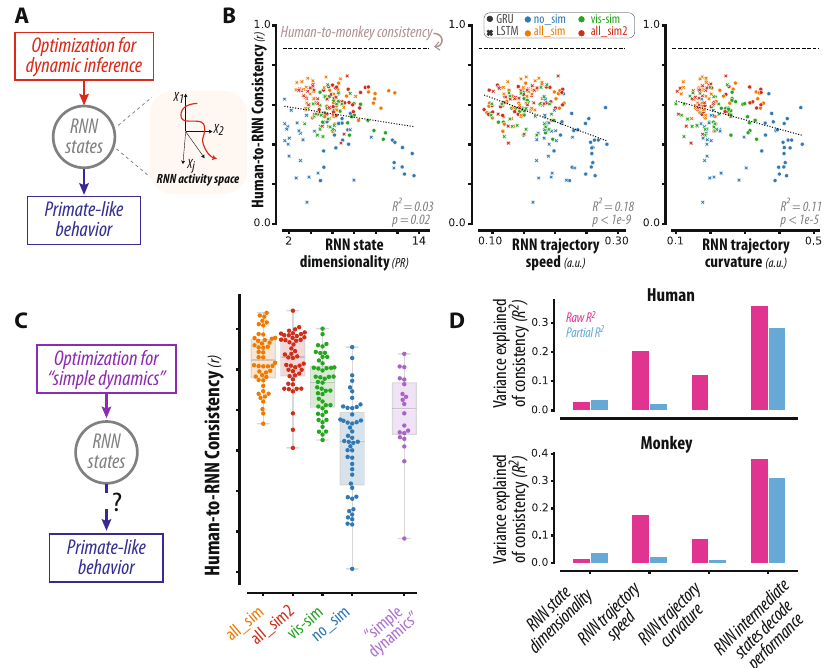
Fig. 4 | RNN Dynamics underlying primate-like behavior. A Optimization for dynamic inference ability in fl uences the network behavior by acting via the inter- mediary of its internal representations. We characterized the structure of the internalrepresentationsofRNNsviaspeci fi cgeometricmetrics. B Eachpanelshows the scatter over all RNN models of a representational attribute (dimensionality, speed,andcurvature)againsthuman-consistency.RNNswithsimpledynamics(i.e., slow, smooth and low dimensional representations) exhibited more human-like behavior ( p <0.02, 0.001, and 0.001 for dimensionality, speed, and curvature respectively). C (left) To assess whether simple dynamics are suf fi cient to capture primate-like behavior, we constructed new RNN models that were identical to the dynamic-inference-optimized models, except for optimization consisting of task performanceandspeci fi cregularizationtermstofavorslowandsmoothdynamics. (right) Distribution of human-consistency scores for all RNNs, grouped by